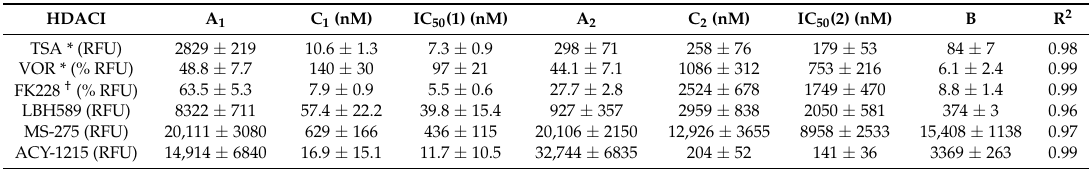
Figure 1. Histone deacetylase (HDAC) activity assays for pan- and class-selective HDAC inhibitors. ( A ) The total HDAC inhibition curve for neonatal mouse ventricular cardiomyocytes treated for 18–24 h with increasing concentrations of panobinostat. Two IC 50 s of approximately 40 and 2000 nM are apparent. ( B ) The cardiomyocyte HDAC inhibition curve for the class I HDAC selective inhibitor entinostat. Again, the HDAC activity curve was best fit with a double exponential function. ( C ) The ventricular cardiomyocyte HDAC inhibition curve for the HDAC6 class IIb HDAC inhibitor ricolinostat exhibits two distinct IC 50 s for total HDAC activity. ( D ) The standard curve for the deacetylated fluorescent Fluor-de-Lys product showing a linear response. All Fluor-de-Lys HDAC activity assays were performed in triplicate and the average ± SEM values are shown. The parameters for the double exponential fits of the dose-response curves are listed in Table 1. Table 1. HDAC inhibitor Activity Assays.